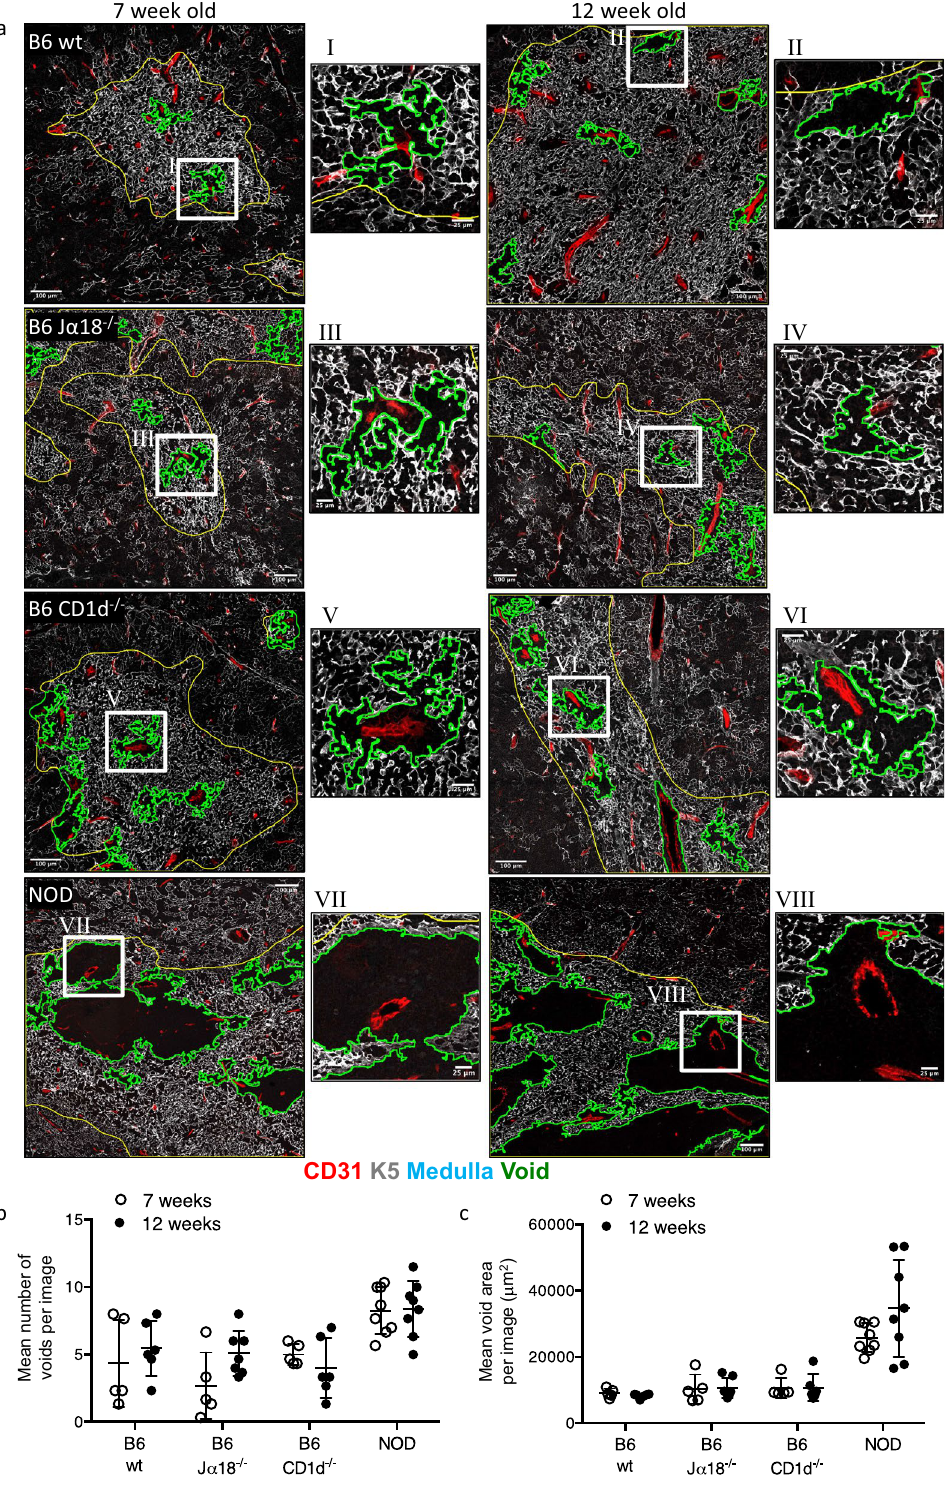
Figure 4. No evidence of an increase in medullary voids in thymuses of NKT cell-deficient mice. B6 WT, B6 Jα18 −/− , B6 CD1d −/− and NOD thymus sections stained with CD31 (Red), cytokeratin 5 (K5), (Gray) and DAPI (not shown). ( a ) Representative image showing medulla (yellow line) and medullary epithelial cell free areas (voids, green lines). Medulla determined from the K5 and DAPI stains and medullary voids determined with the use of an ImageJ script and defined as spaces within the medulla lacking in K5 stain and > 5000 µm 2 in area. Scale bar 100 µm of each main image and 25 µm of zoom region. ( b ) Mean number of voids and ( c ) mean void area per mouse. Microscopy images acquired with Zen 2012 (ZEISS ZEN Microscope Software for Microscope Components) and processed with FIJI/ImageJ (Fiji (imagej.net)) and figure compiled with Microsoft PowerPoint (Microsoft PowerPoint Slide Presentation Software|Microsoft 365). Symbols represent mean from 3–4 images per mouse, n = 2–4 mice per group, combined from 2 independent experiments, mean ±